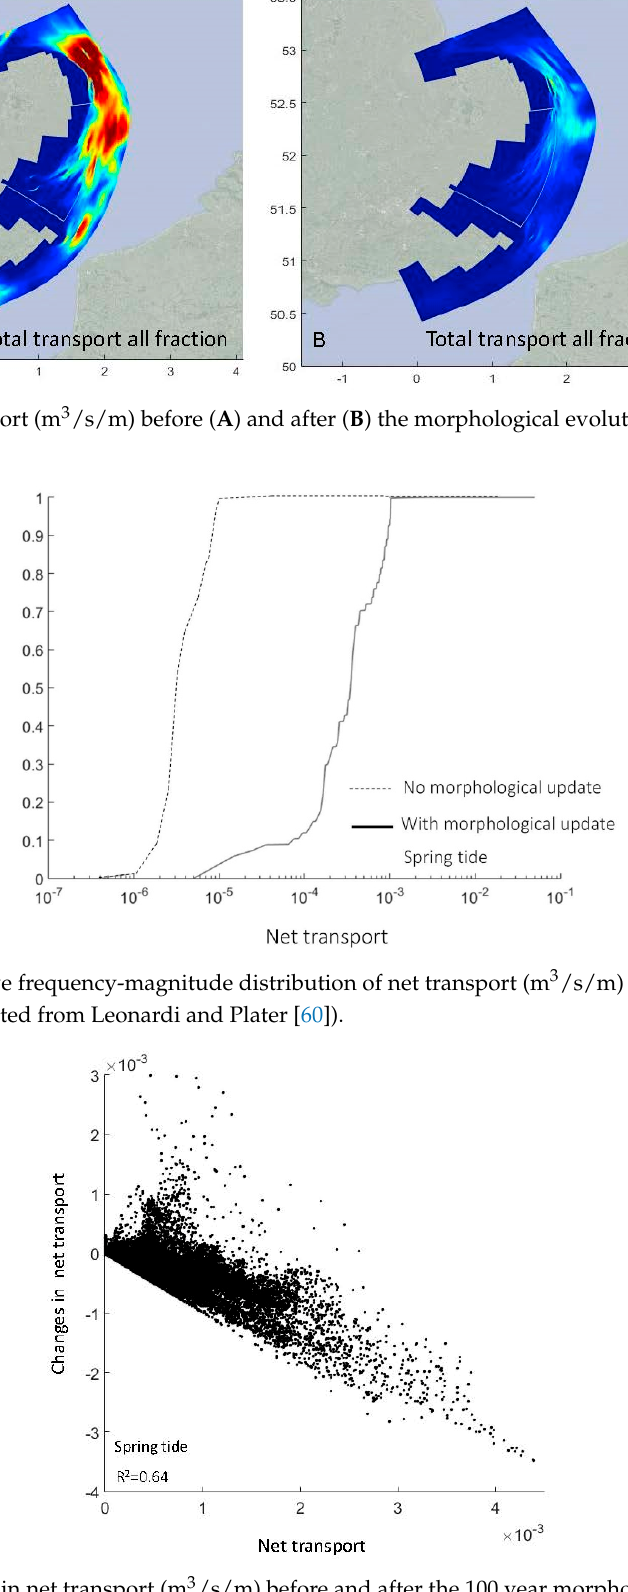
Figure 6. Difference in net transport (m 3 /s/m) before and after the 100 year morphological evolution of the system (no sea level rise scenario), and as a function of net transport values obtained from the simulation having original bathymetric values. Points refer to the entire